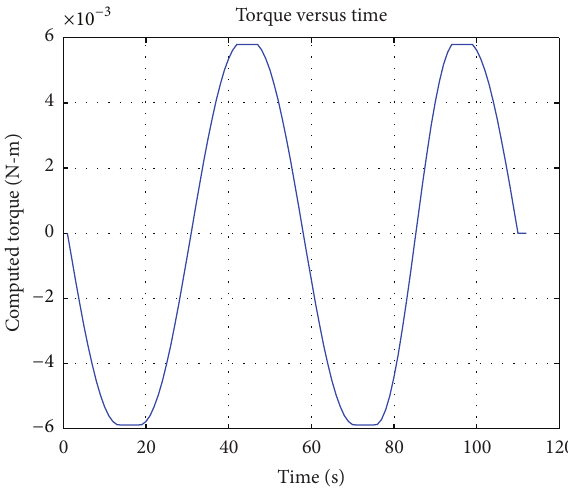
Figure 24: Joint torque graph at wrist due to flexion and extension.